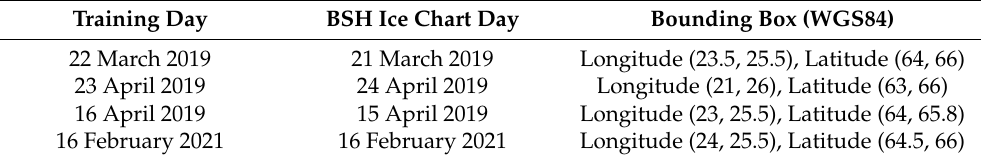
Table 4. Stage of Development